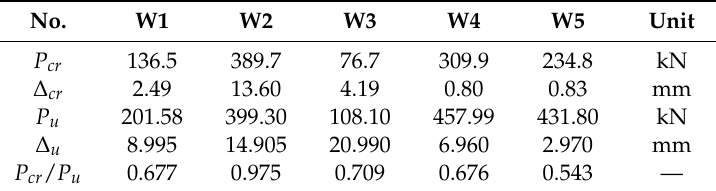
Table 4. Characteristic load and displacement.